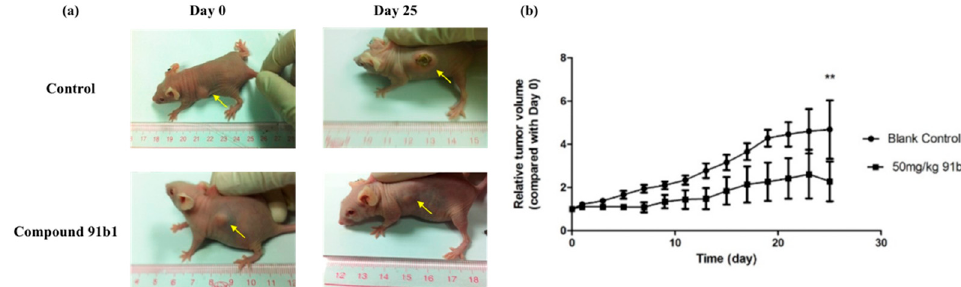
Figure 2. Compound 91b1 inhibited tumor growth in vivo. ( a ) Images of one animal from the vehicle control group and compound 91b1-treated group in the KYSE150 xenograft test on the first day and the 25th day; ( b ) relative tumor volume changes of subcutaneous KYSE150 xenografts of the vehicle control group and compound 91b1-treated group (50 mg/kg/day compound 91b1) after 25 days; 6% PEG saline was applied as the vehicle control. N = 5. ** p -value < 0.05.